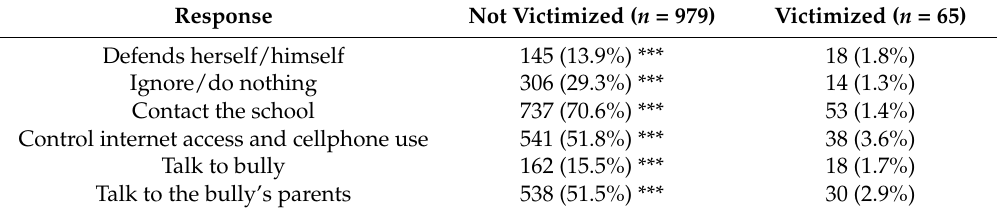
Table 5. Percentages of the parents’ responses according to the adolescents’ self-reported